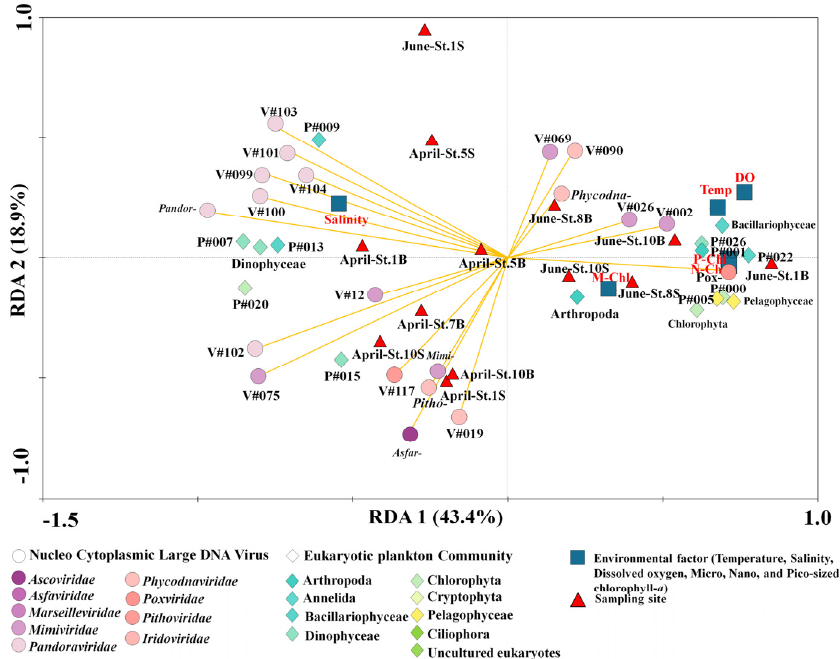
Figure 6. Redundancy analysis (RDA) ordinations of 14 common nucleocytoplasmic large DNA viruses (NCLDVs; common NCLDV operational taxonomic units (vOTUs) and six NCLDVs family selected the mean relative abundances of 1%) analysed using ten common eukaryotic plankton communities (EPCs; common plankton OTUs selected the mean relative abundances of 1%), two phyla, three classe.s, and six environmental factors from 13 sampling sites in the Sub–Arctic Kongsfjorden in April and June 2018. Correlations among the environmental factors (red color), pOTUs of EPC (green color), and NCLDVs vOTUs (orange arrow lines) are shown. The first two RDA axes are represented by the length and angle of the arrows, respectively. Detailed information on species names for each OTU number is described in Table S4.